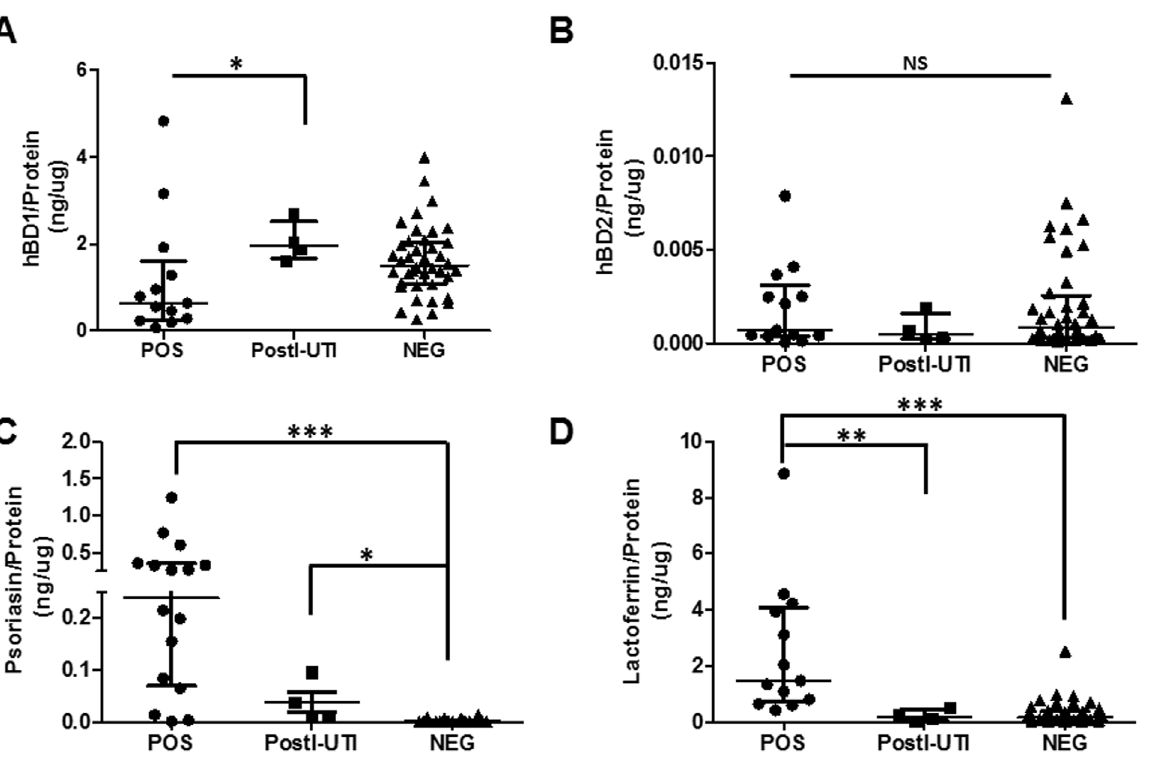
Fig. 3. Urinary AMP protein levels in each UTI cohort. Urinary AMP levels were determined by ELISA and normalized to total urinary protein. A. human b - defensin-1 (HBD1) normalized to total protein. B. human b -defensin-2 (HBD2) normalized to total protein. C. Psoriasin normalized to total protein. D. Lactoferrin normalized to total protein. *p , 0.05; **p , 0.01; ***p , 0.001 by One-way ANOVA and Dunn’s post-test. Median with interquartile range is shown for each